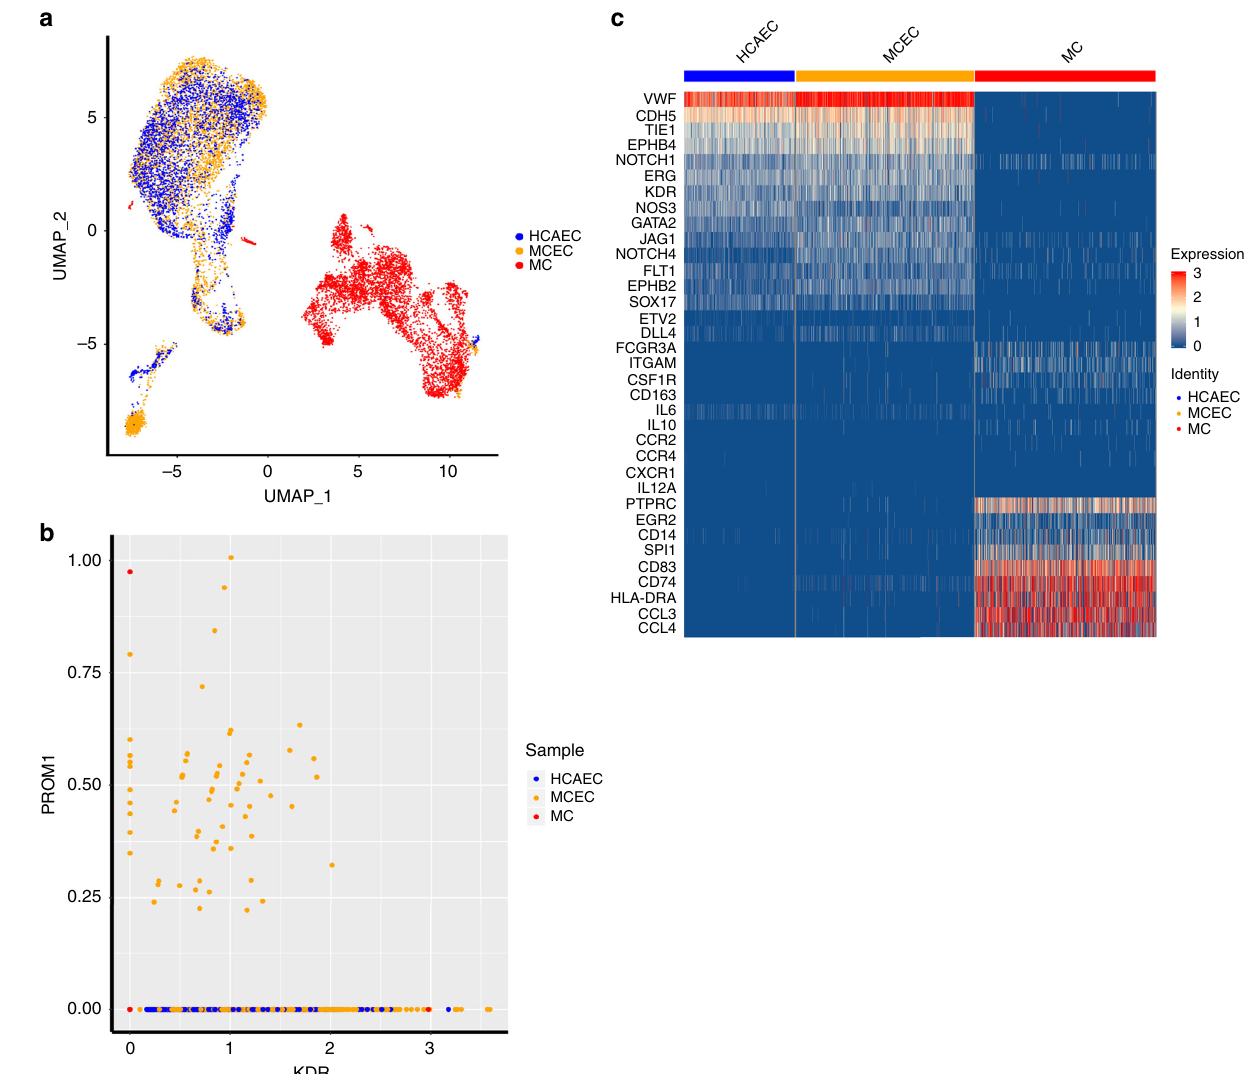
Fig. 9 Single-cell RNA sequencing. Single-cell RNA sequencing of three cell populations, initial MC, MCEC, and HCAEC both subjected to shear stress. a UMAP reduction analysis of unsupervised data of all three cell populations. b Co-expression analysis of KDR and PROM1 expression across all three populations. MC do not express KDR or PROM1. c Heat map representation of MC, M1, M2, and EC genes across all three